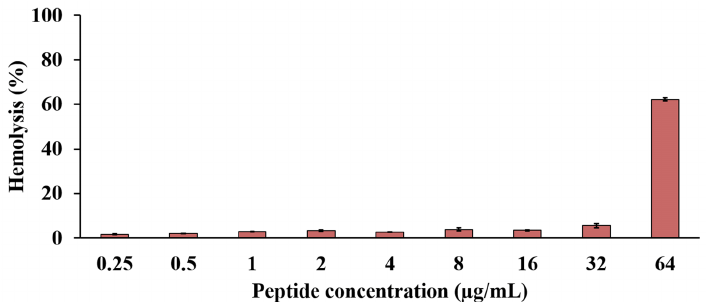
Figure 10. Lysis of human erythrocytes by the anti-MRSA peptide (P1). The peptide was prepared in concentrations between 0.25 and 64 μg/mL. The result is represented by % hemolysis, which was calculated by measuring the absorbance at 540 nm compared to 1% Triton X-100 as the positive control.